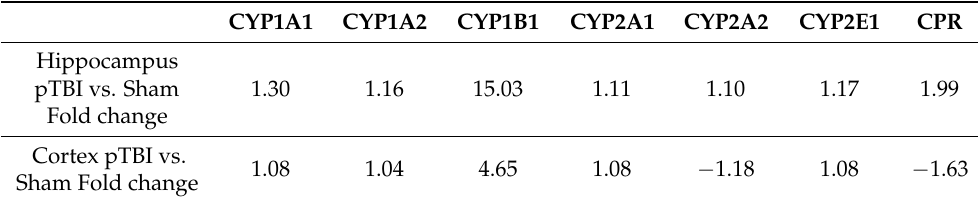
Table A1. Data extracted from gen array of whole hippocampi and cortical tissue from rats subjected to sham-surgery or pTBI [3].